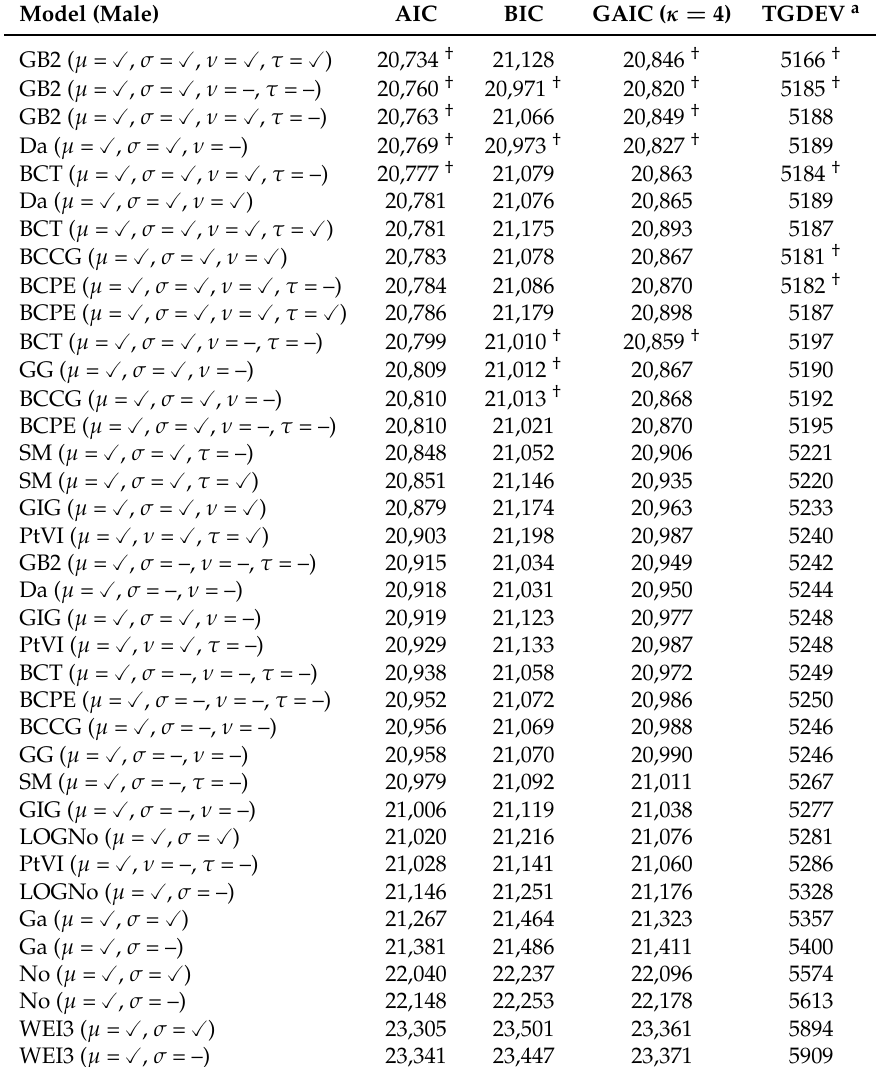
Table A2. Information criteria of estimated models with the male